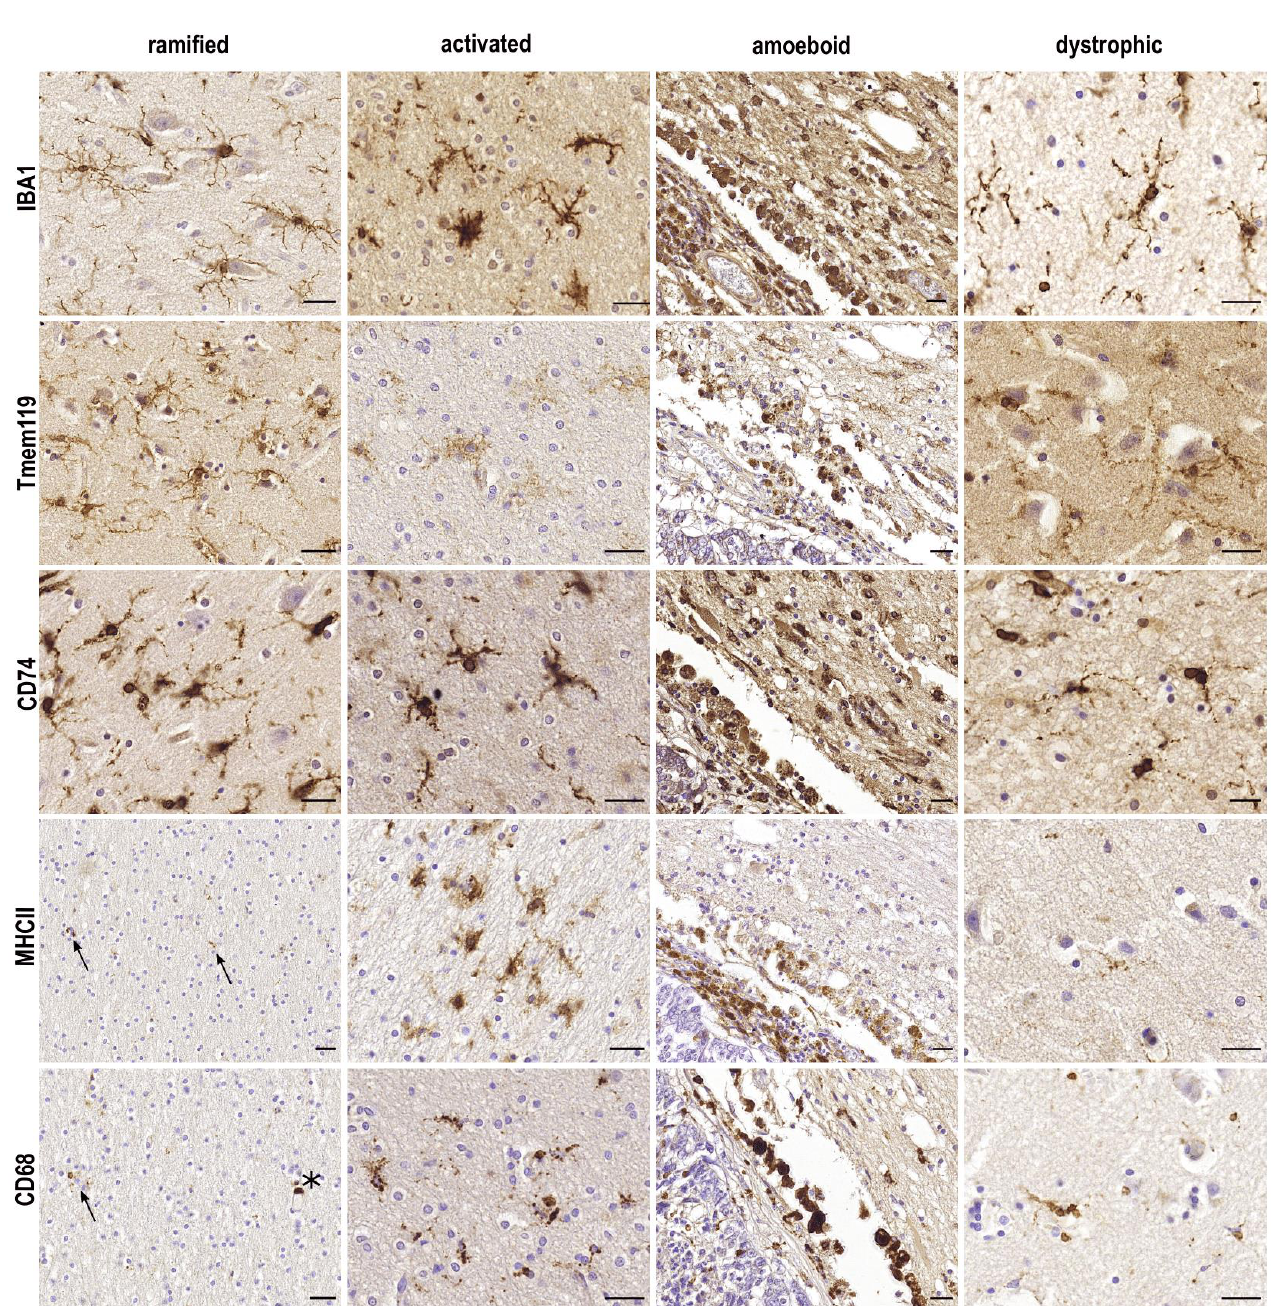
Figure 1. Comparison of frequently used microglial markers in the typically described morphological phenotypes . In human tissue from the frontal cortex and hippocampus, most markers show a distinct expression profile in the typically described morphological phenotypes. While IBA1 and CD74 are expressed by all phenotypes, TMEM119 is reduced in activated microglia. Marginal expression of MHCII and CD68 can be observed on parenchymal microglia ( ↑ ), while strong expression of perivascular macrophages is shown (*). Amoeboid microglia can be observed on the rim of a metastatic adenocarcinoma in the hippocampus. Scale bars: 25 µm.